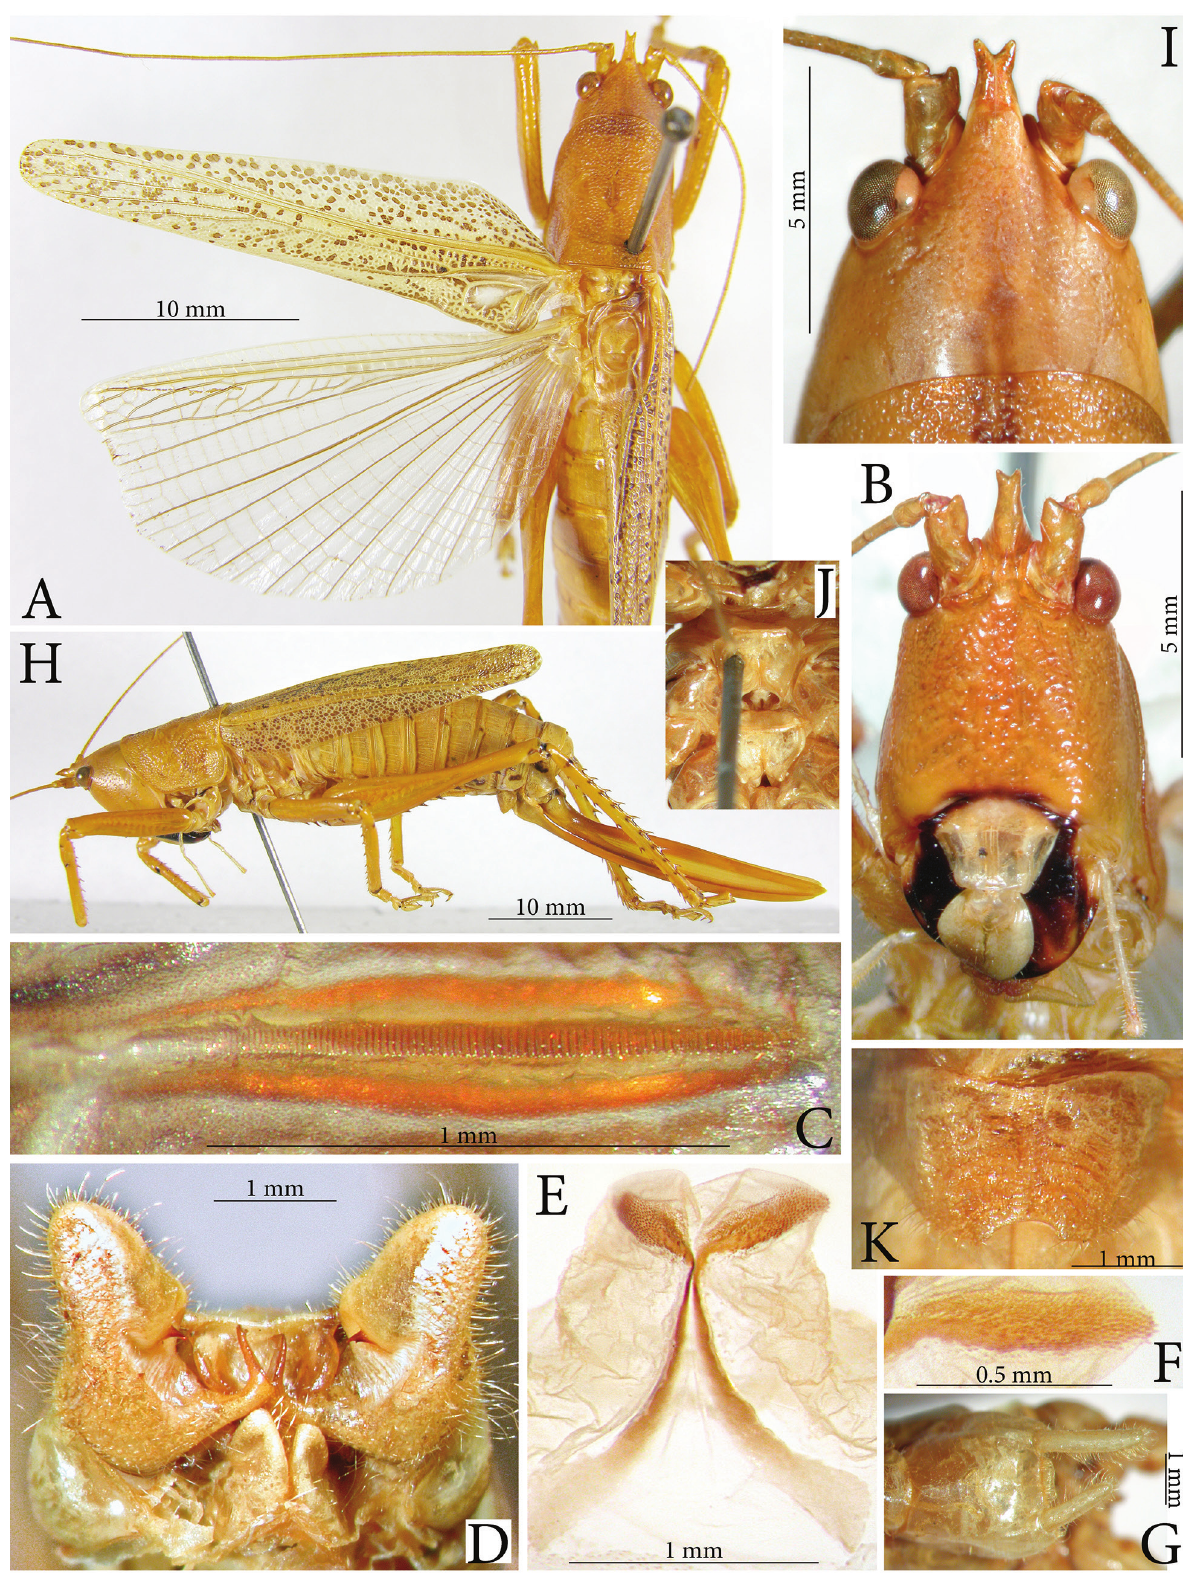
Figure 5. Liara ( Indoliara ) dividata sp. nov. A–G male holotype: A habitus dorsal view; B face; C stridulatory file; D abdominal apex with cerci in ventro-apical view; E titillators of male phallus; F tip of titillators; G subgenital plate. – H–K female: H habitus lateral view; I head in dorsal view; J thoracic sternites; K subgenital